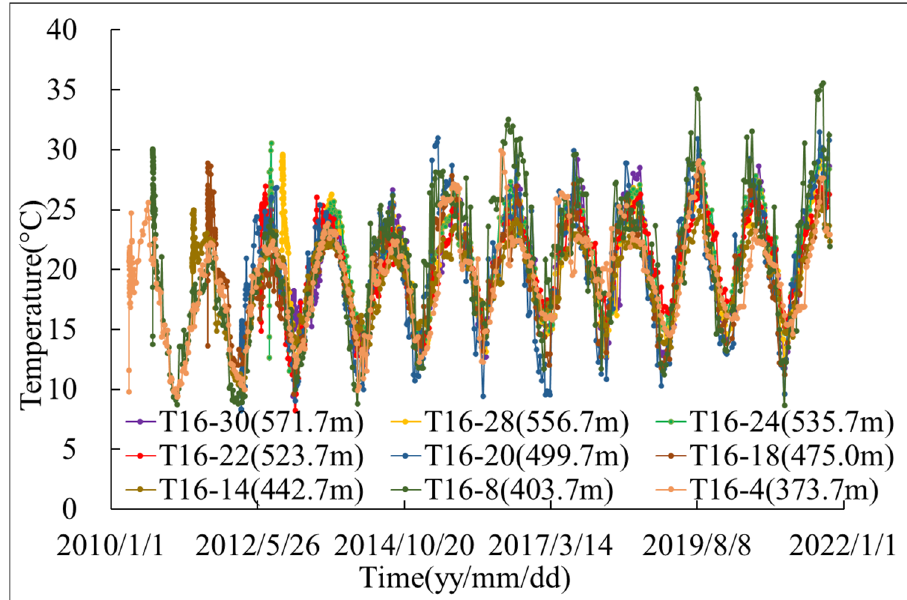
Figure 4. Temperature change process line of thermometer measuring points on the downstream surface of cantilever No. 16 dam section.